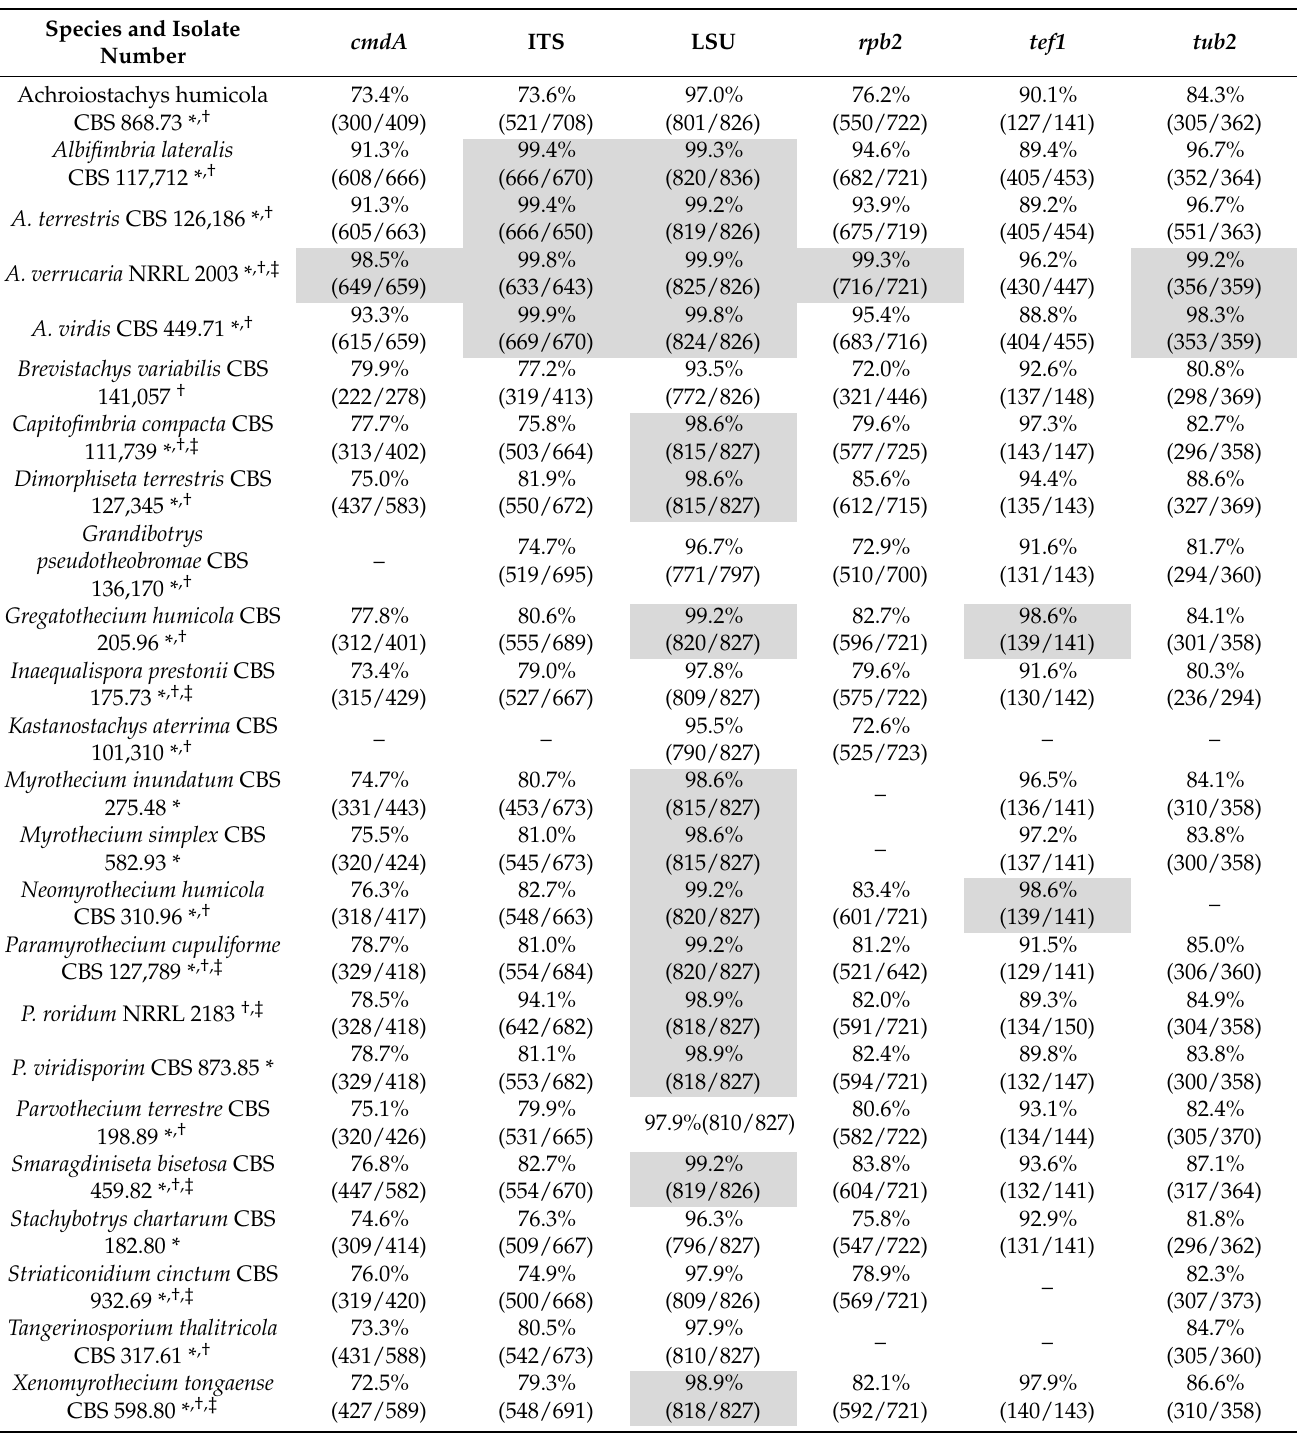
Table 1. Genetic similarity of Albifimbria verrucaria strain CABI-IMI 368,023 to other Albifimbria taxa and select Stachybotriaceae . Presented are percent identical sequences with the number of exact matches/total length presented parenthetically following BLASTn comparisons for the genes calmodulin ( cmdA ), internal transcribed spacer 5.8S (ITS), 28S RNA large subunit (LSU), RNA polymerase II second subunit ( rpb2 ), translation elongation factor 1-alpha ( tef1 ) and beta-tubulin ( tub2 ). Accession numbers for the gene sequences used are presented in Lombard et al. (2016). Instances of >98% identity are highlighted in